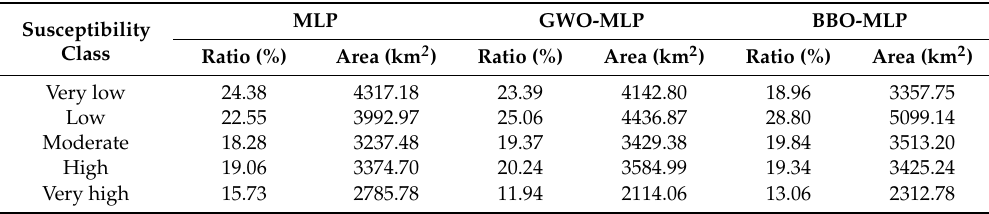
Table 2. The ratio and area of each susceptibility class.